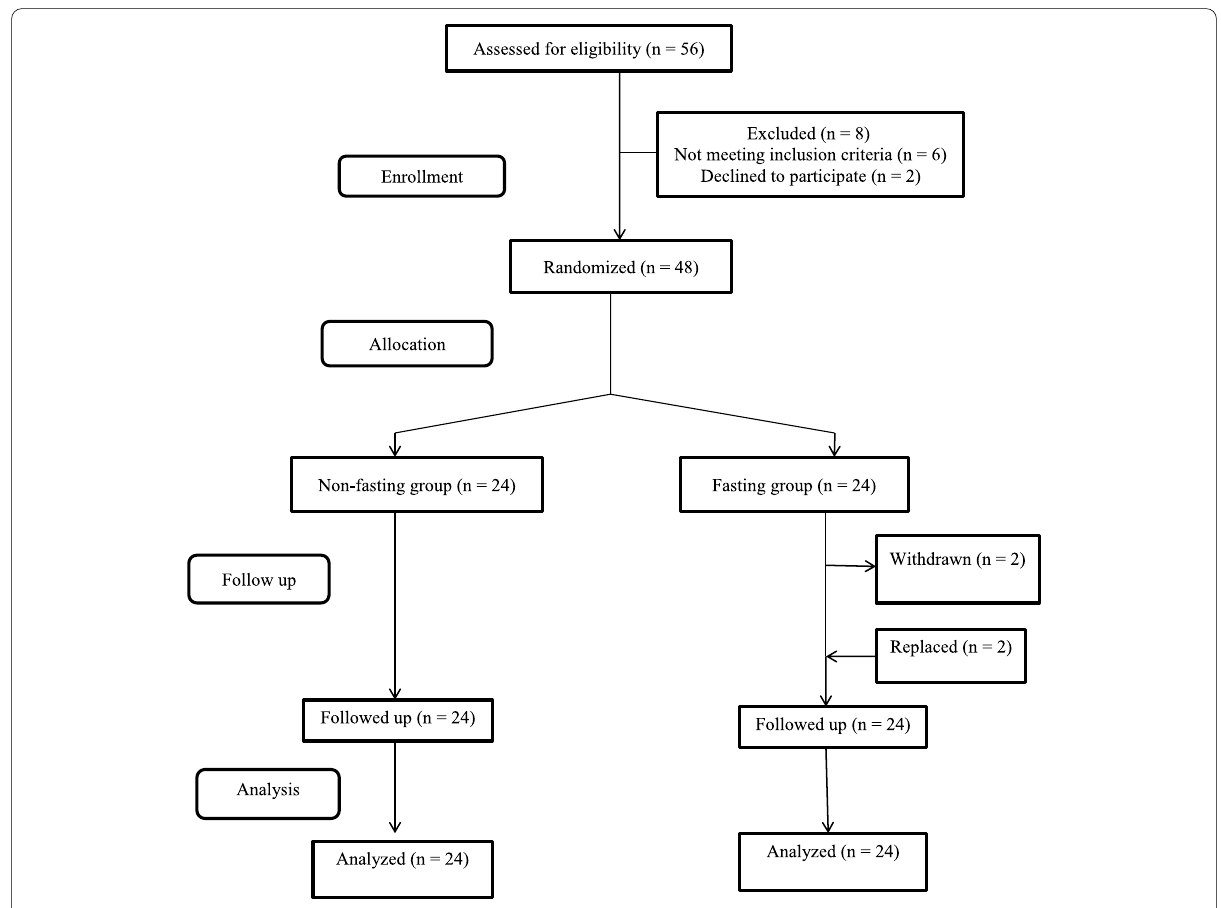
Fig. 1 The study flow